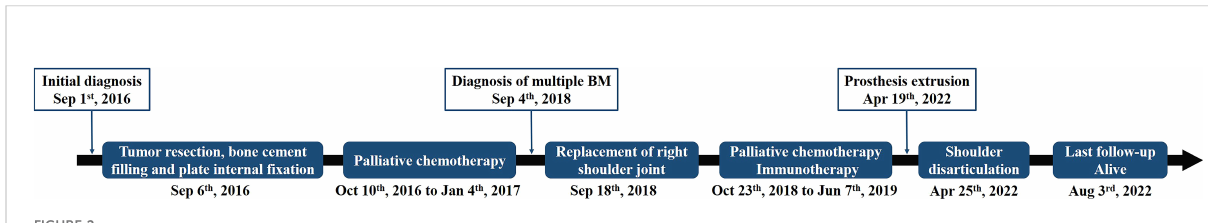
FIGURE 2 The timeline of the diagnosis and treatment course of the patient in the present